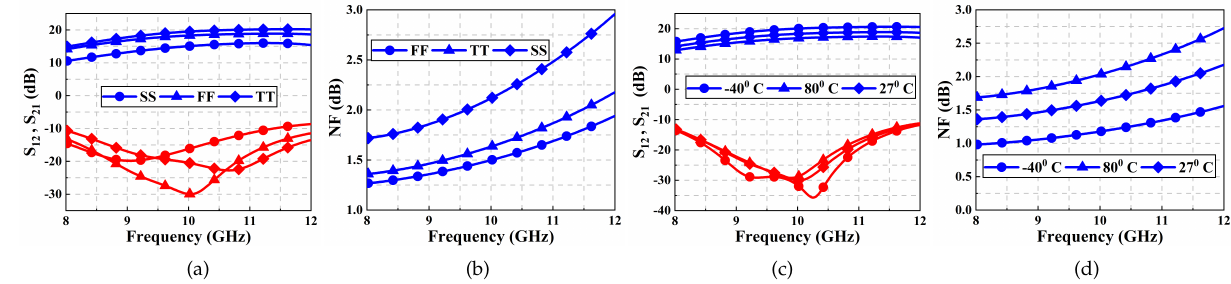
Figure 17. PVT simulation results of S-parameters and NF of the proposed LNA. ( a ) process corner simulations at TT–FF–SS of S-parameters; ( b ) process corner simulations at TT–FF–SS of NF; ( c ) temperature variation simulations of S-parameters; ( d ) temperature variation simulations of